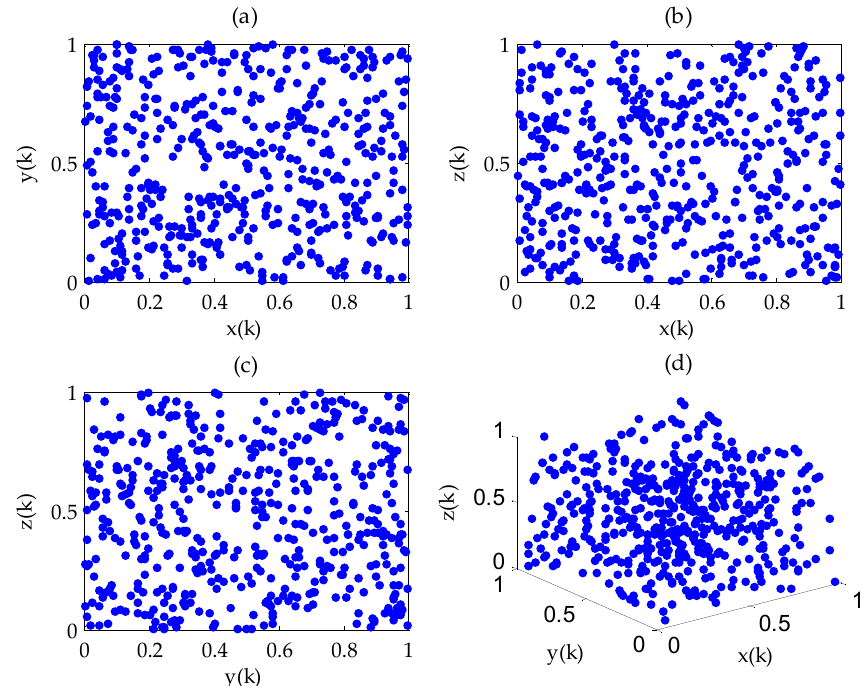
Figure 9. Phase diagram of system (3): ( a ) X–Y phase diagram; ( b ) X–Z phase diagram; ( c ) Y–Z phase diagram; ( d ) X–Y–Z phase diagram.